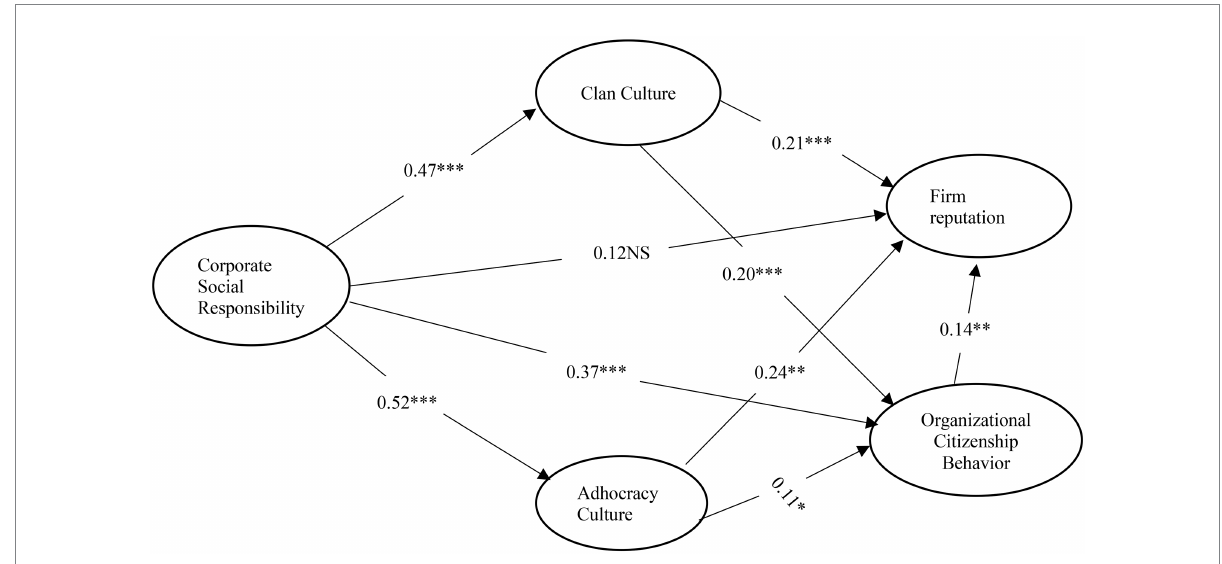
FIGURE 2 SEM modeling. significant at *** p < 0.01 and ** p <